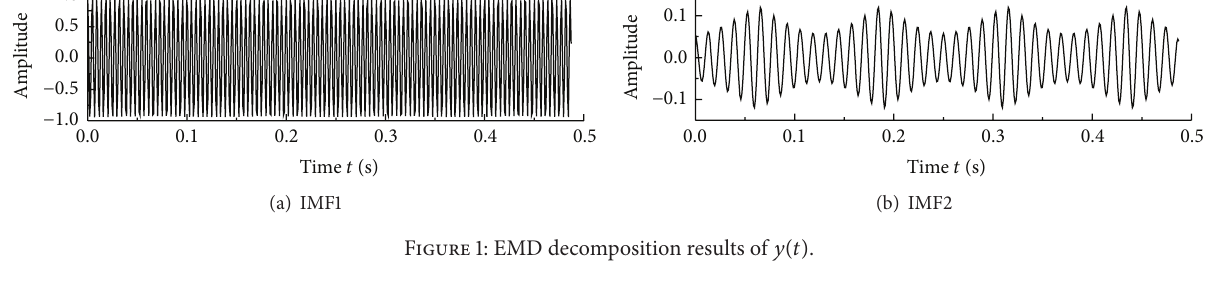
Figure 1: EMD decomposition results of 𝑦(𝑡) .